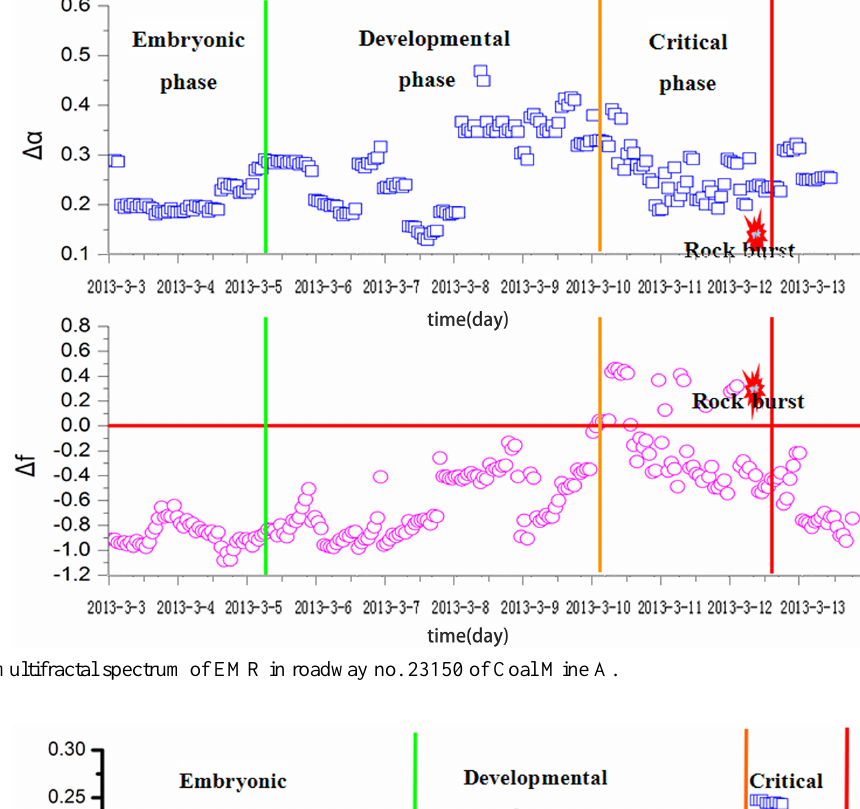
Figure 8. Temporal multifractal spectrum of EMR in roadway no. 23150 of Coal Mine A.